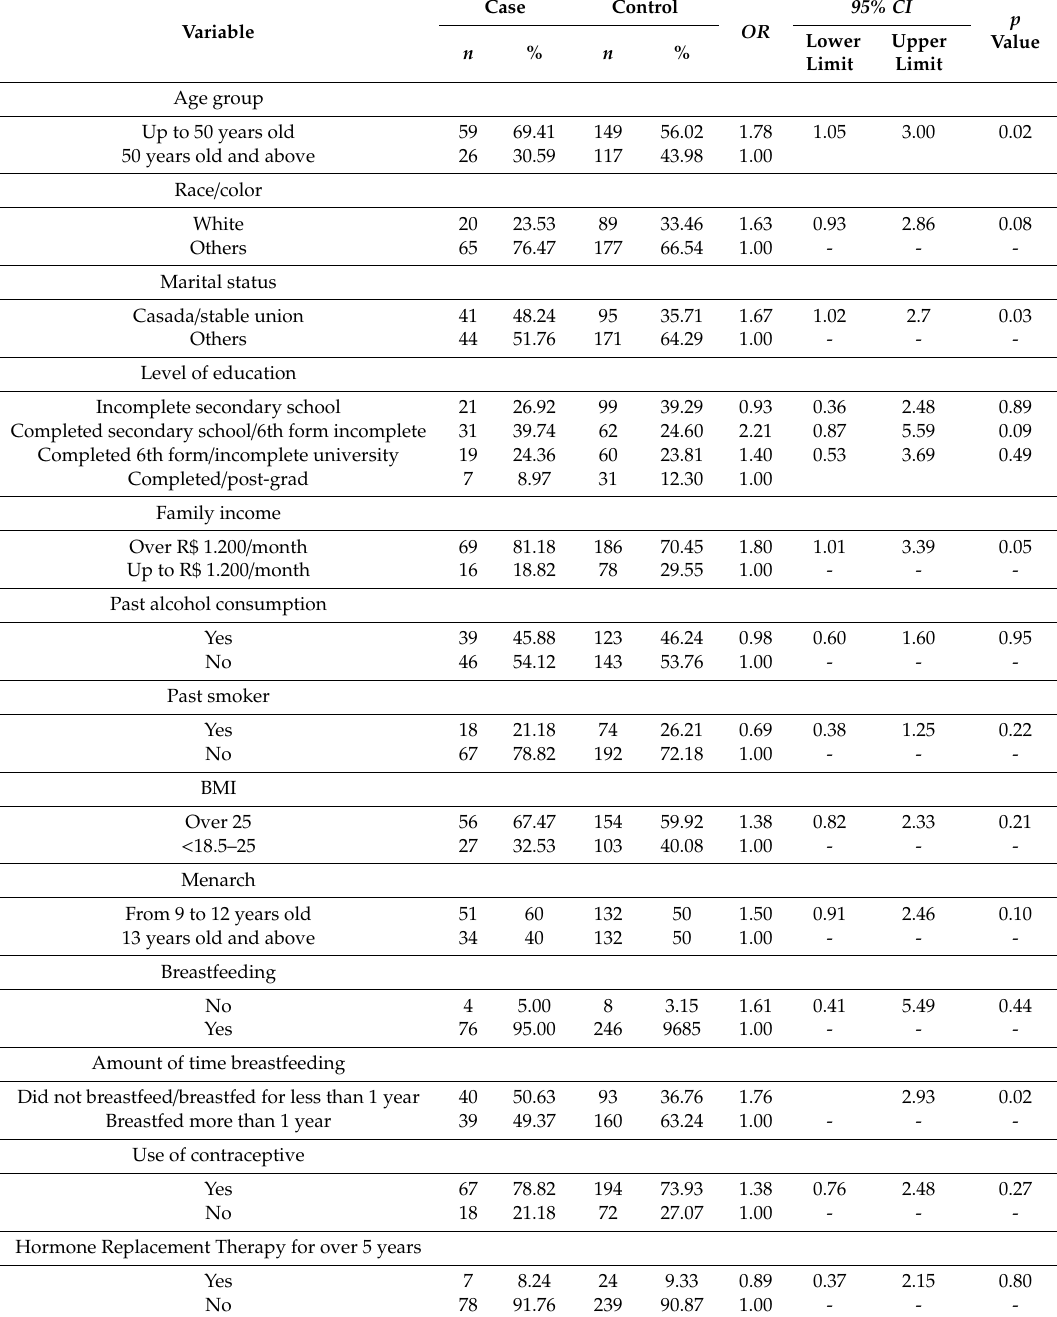
Table2. Bivariateanalysisofsocio-demographicfactorsandbreastcancer, Rondon ó polis-MT,November 2017 to April